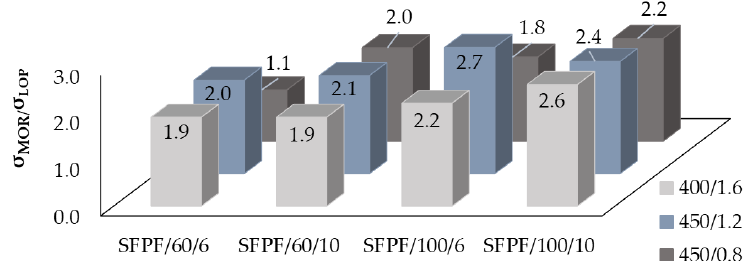
Figure 15. Graphs of the σ MOR / σ LOP ratio for SFPF (single fibrillated-tapes polypropylene fibers) depending on the length and amount of fibers.